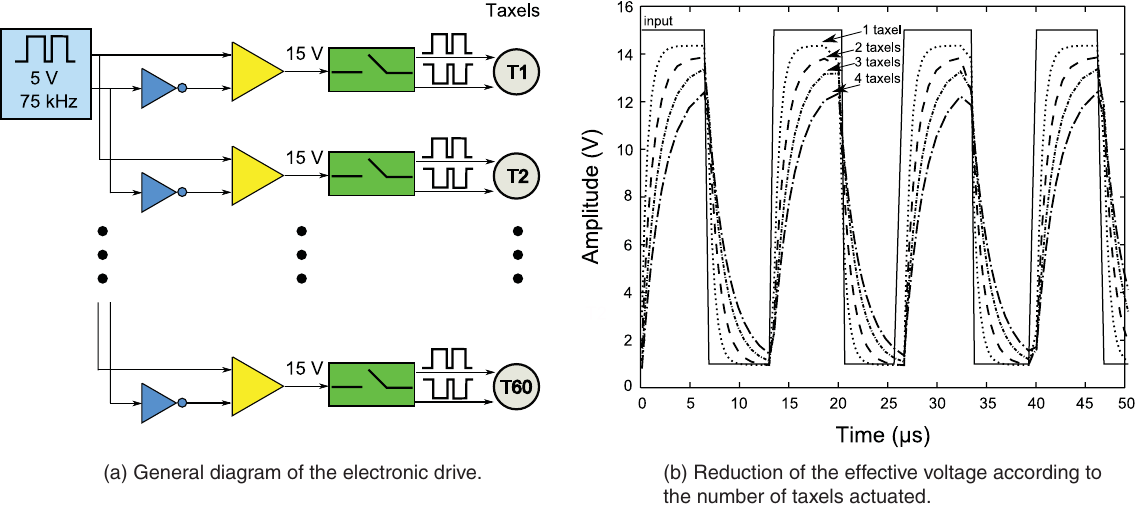
Fig. 15. Electronic drive for the Braille